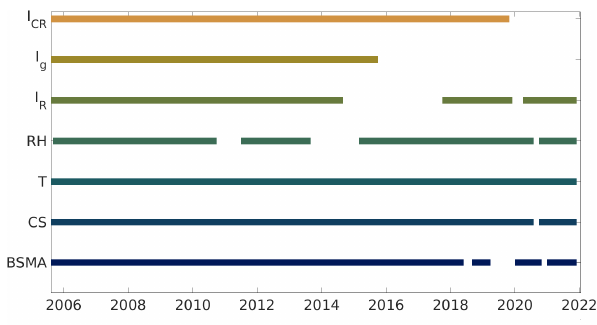
Figure 2. Time periods when data are available for variables we used in our analysis. I CR is the cosmic ray ionization rate, I g is the gamma ionization rate, I R is the radon ionization rate, RH is relative humidity, T is temperature, and CS is the condensation sink. BSMA is the ion spectrometer used in the